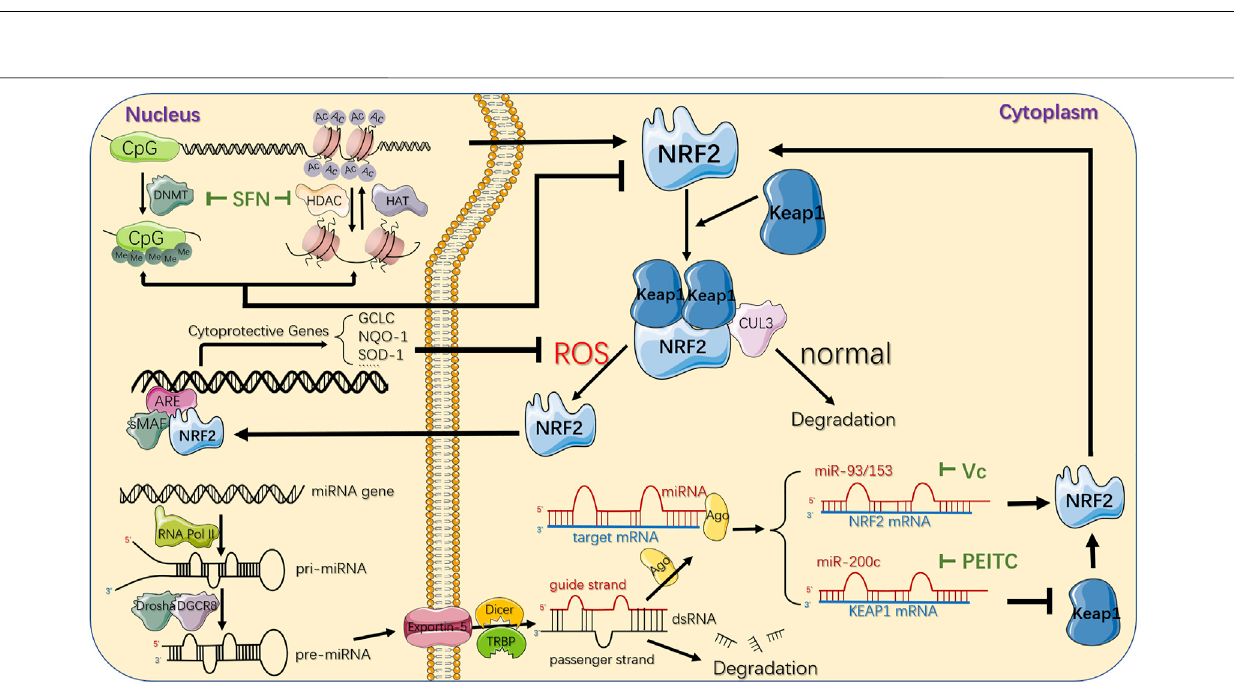
FIGURE4| EpigeneticmechanismsandtherapeuticstrategiestargetingNRF2/KEAP1pathway. CpGsitesofNFE2L2promoterregioncanbeepigeneticallymodi fi ed byDNMT-basedmethylation,whilehistoneacetylationismaintainedbythecoordinationofHATsandHDACs,whichacetylateordeacetylatethelysineresiduesintheN-terminal tails of histones protruding from the octamer respectively. SFN, a natural phytochemical, primarily attenuates both DNMTs and HDACs, individually suppressing DNA